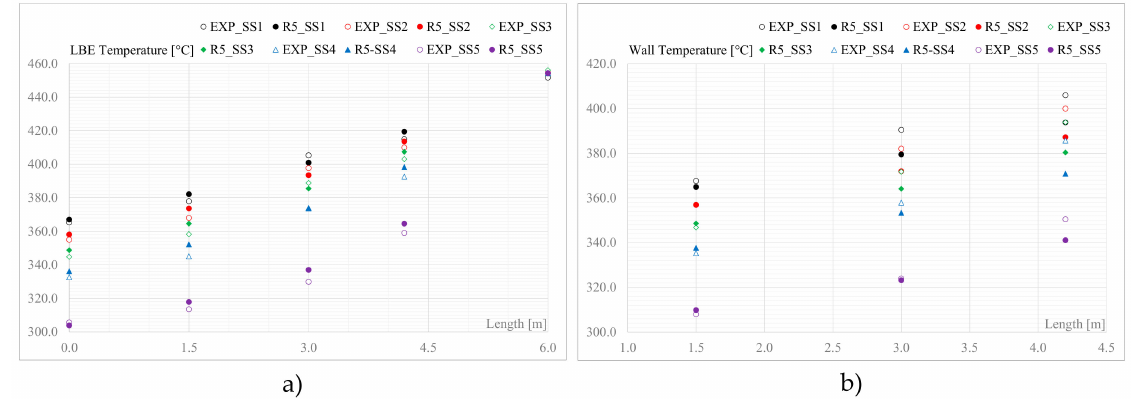
Figure 11. EF-T1, exp. vs. RELAP5-3D: ( a ) SG LBE bulk temperatures; ( b ) wall temperatures.